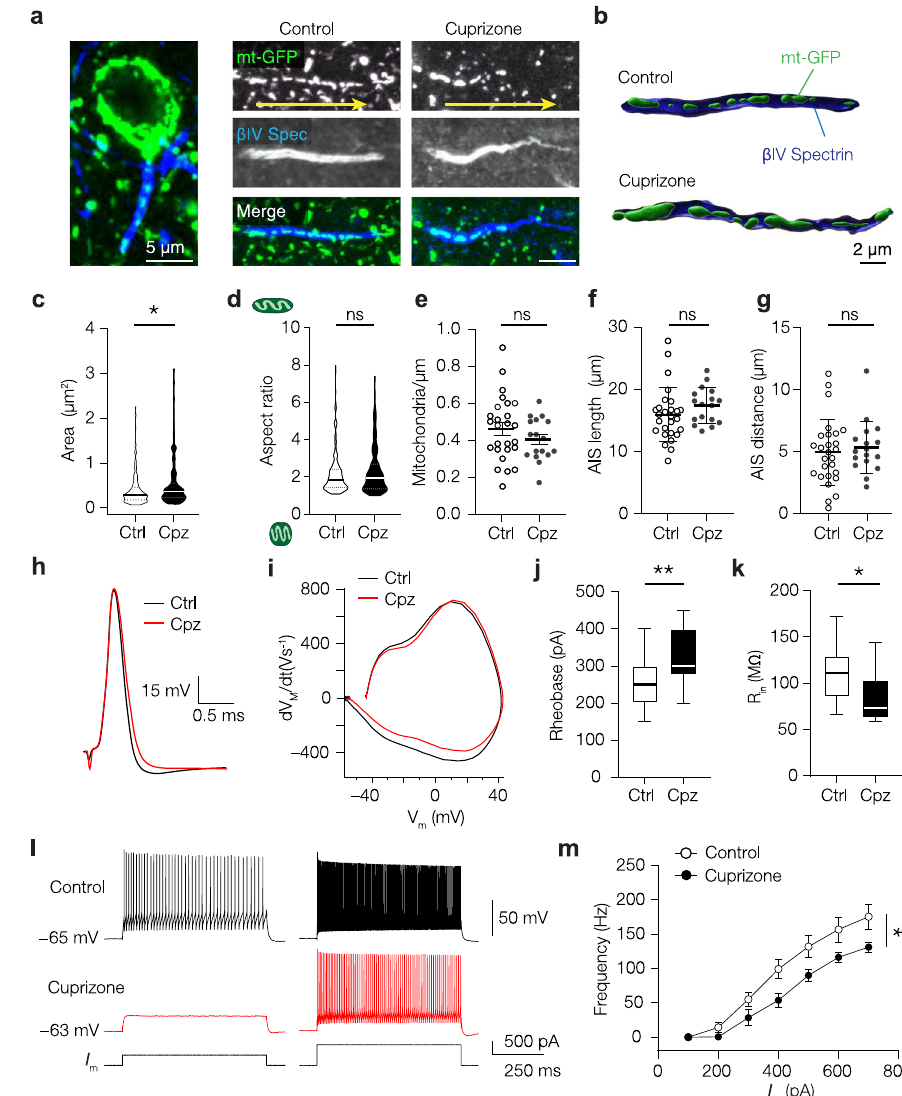
Fig. 2 | Cuprizone-induced demyelination enlarges AIS mitochondria and reducesPV + interneuronexcitability.a Exampleimagesofmitochondria(green) at the AIS (blue) of PV + interneurons. Arrows (yellow) indicate anterograde direc- tionof theaxon.Similarresultswereobtained in7mice. b 3Dsurfacerenderingof PV + AISs containing mitochondria of control or cuprizone-treated axons. c Mitochondrial area is increased upon demyelination (two-sided nested t-test, * P =0.0241; df= 43; Ctrl, n =215mitochondria in 27AISsfrom 4 mice; Cpz, n =144 mitochondria in 18 AISs from 3 mice). d Mitochondrial aspect ratio is unaffected (two-sided nested t-test, P =0.5656; df = 43; Ctrl, n =215 mitochondria in 27 AISs from 4 mice; Cpz, n =144 mitochondria in 18 AISs from 3 mice). e Density of AIS mitochondria is unchanged upon demyelination (two-sided unpaired t-test , P =0.2396;df=41;Ctrl, n =26AISsfrom4mice;Cpz, n =17AISsfrom3mice). f AIS lengthisunaffected by cuprizone treatment (two-sided unpaired t-test, P =0.2112; df = 42; Ctrl, n =27 AISs from 4 mice; Cpz, n =17 AISs from 3 mice). g AIS distance (soma edge to AIS) is comparable between control and cuprizone-treated groups (two-sided unpaired t-test, P =0.6055; df = 42; Ctrl, n =27 AISs from 4 mice; Cpz, n =17 AISs from 3 mice). h Example single APs of a control and demyelinated PV +